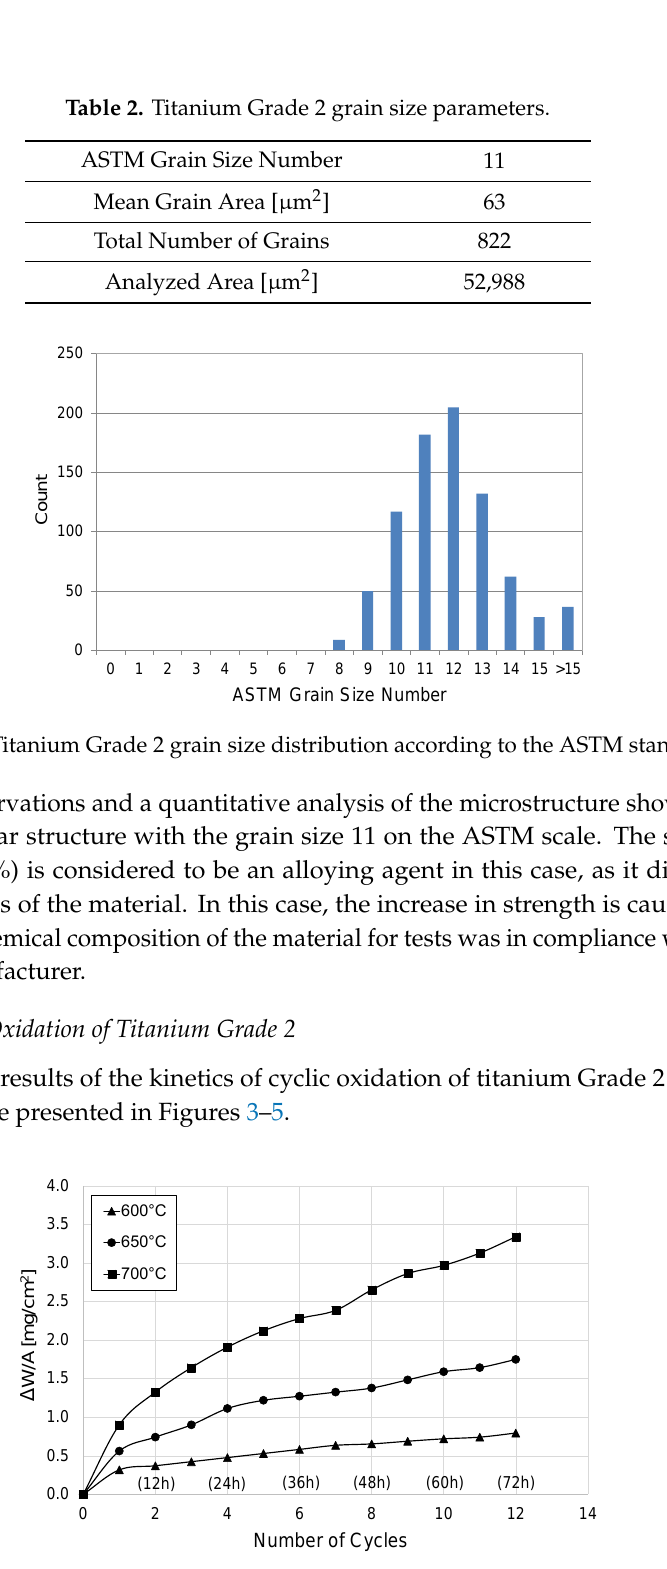
Figure 3. Kinetics of cyclic oxidation of titanium Grade 2 at temperatures of 600, 650 and 700 °C, depending on the number of cycles (1 cycle = 6 h).